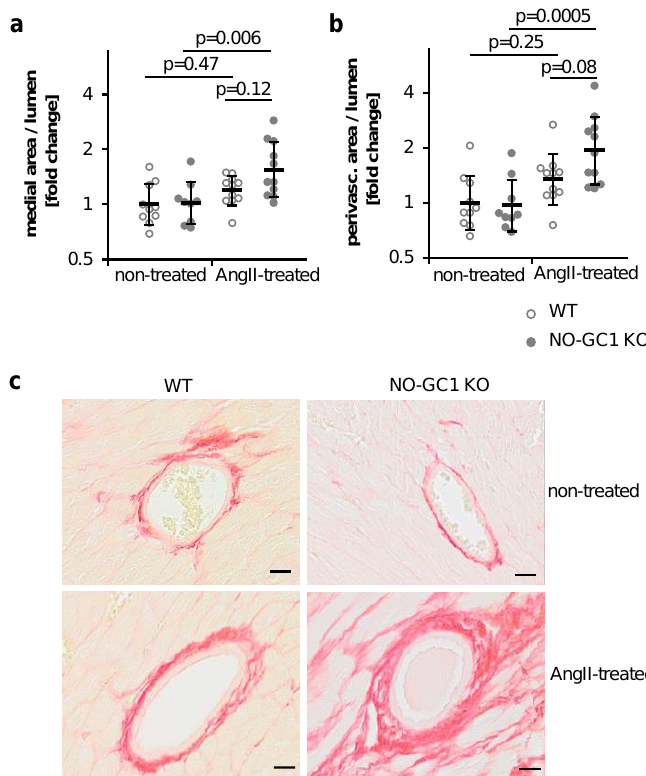
Figure 2. AngII induces an increase of perivascular area of cardiac vessels in NO-GC1 KO mice. ( a ) Media to lumen and ( b ) perivascular to lumen ratios of cardiac vessels were determined in picrosirius red-stained heart slices from non-treated and AngII-treated WT and NO-GC1 KO mice. Values are normalized to media to lumen ratio and perivascular area to lumen ratio of WT (in a: 0.59; in b: 0.53). Because residuals were not normally distributed, individual values were log-transformed and statistically analyzed. For graphical representation, original (not-transformed) values are shown in semi-log plots as individual values (per animal) together with geometric means ± geometric SD. ( c ) Representative cross sections (5 µ m) of cardiac vessels from non-treated and AngII-treated WT and NO-GC1 KO mice stained with picrosirius red (for collagen). Scale bar, 20 µ m.